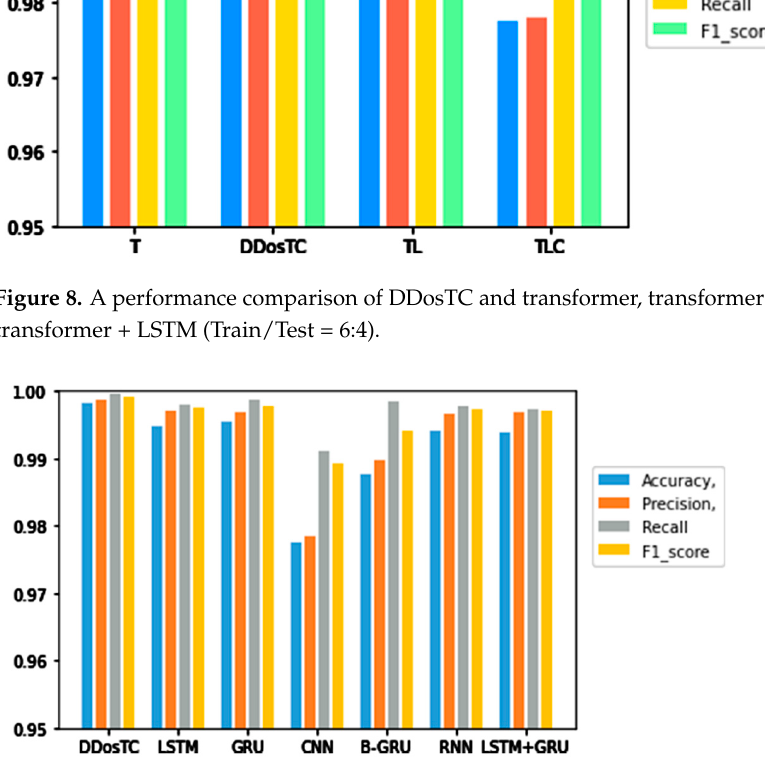
Figure 9. Accuracy, precision, recall rate, and F1 score results for DDosTC and other test methods with a training set/test set ratio of 8:2.